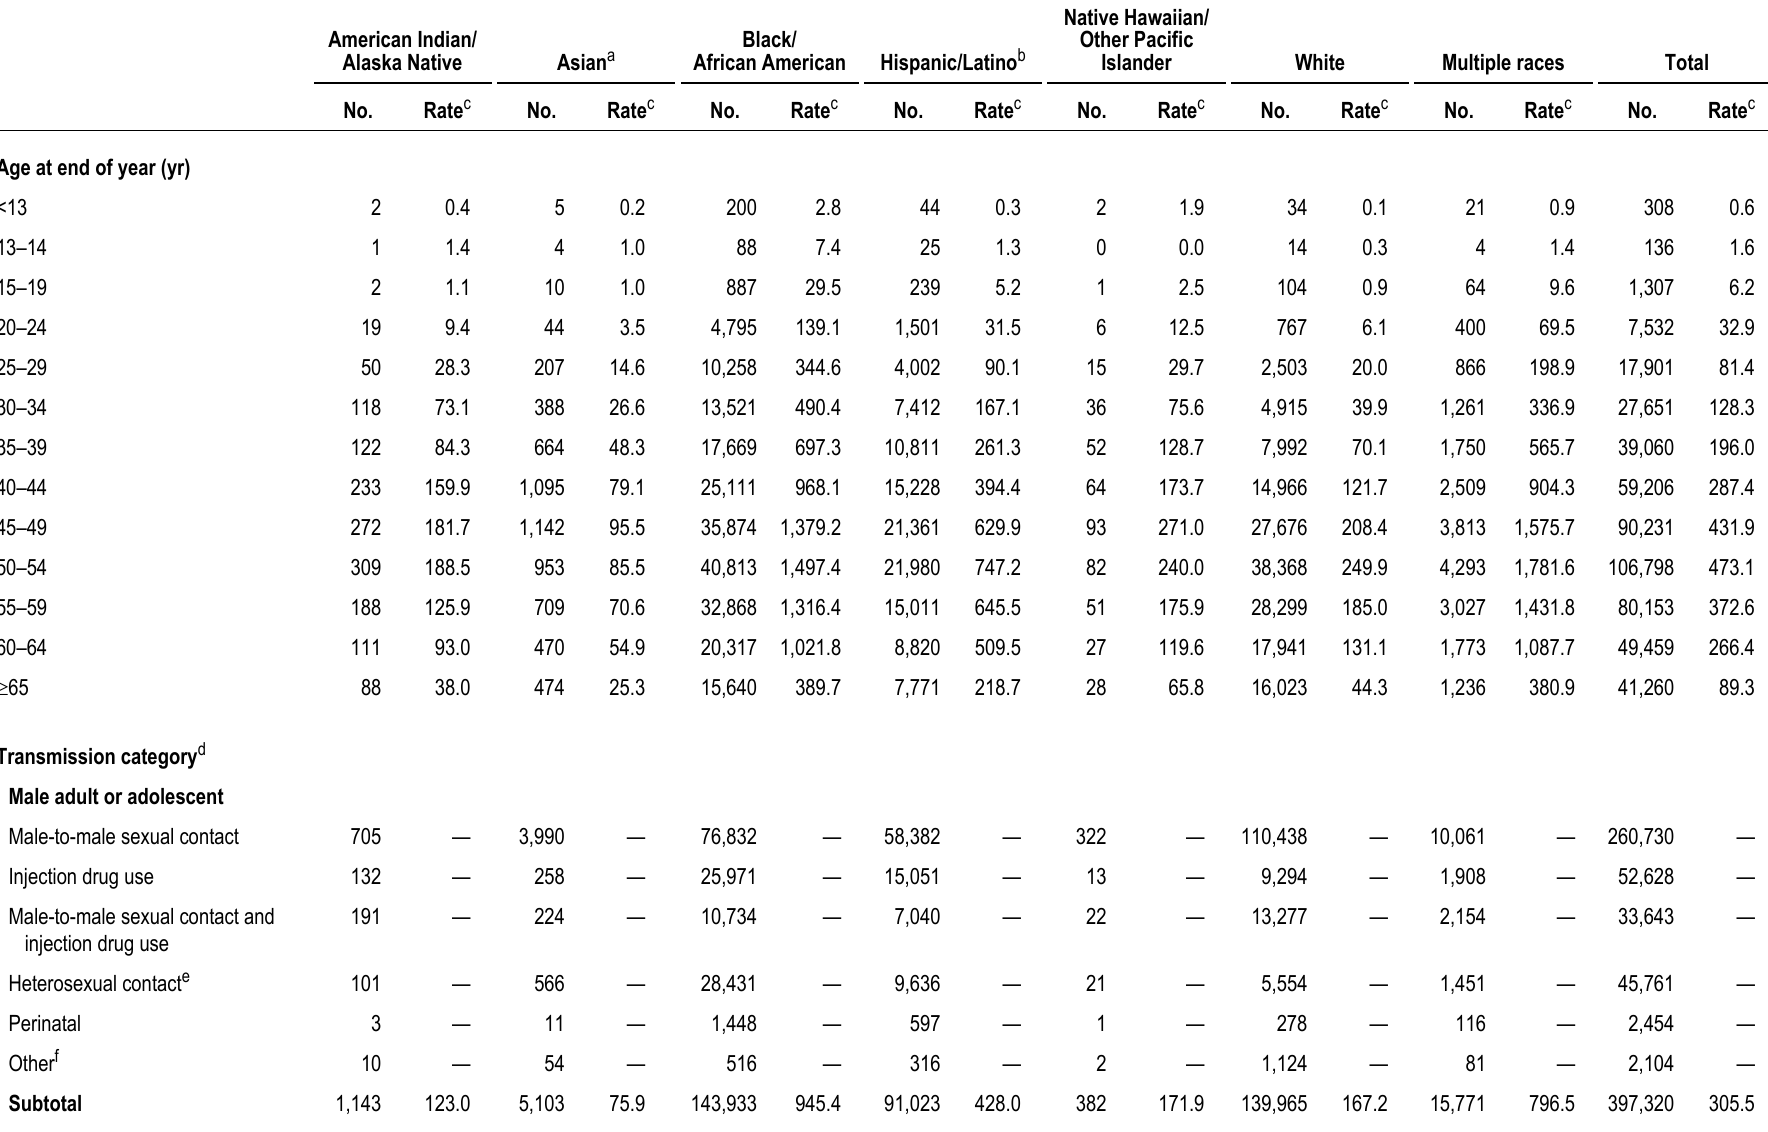
Table 21a. Persons living with diagnosed HIV infection ever classified as stage 3 (AIDS), by race/ethnicity and selected characteristics, year-end 2014—United States Native Hawaiian/ American Indian/ Black/ Other Pacific Alaska Native Asian a African American Hispanic/Latino b Islander White Multiple